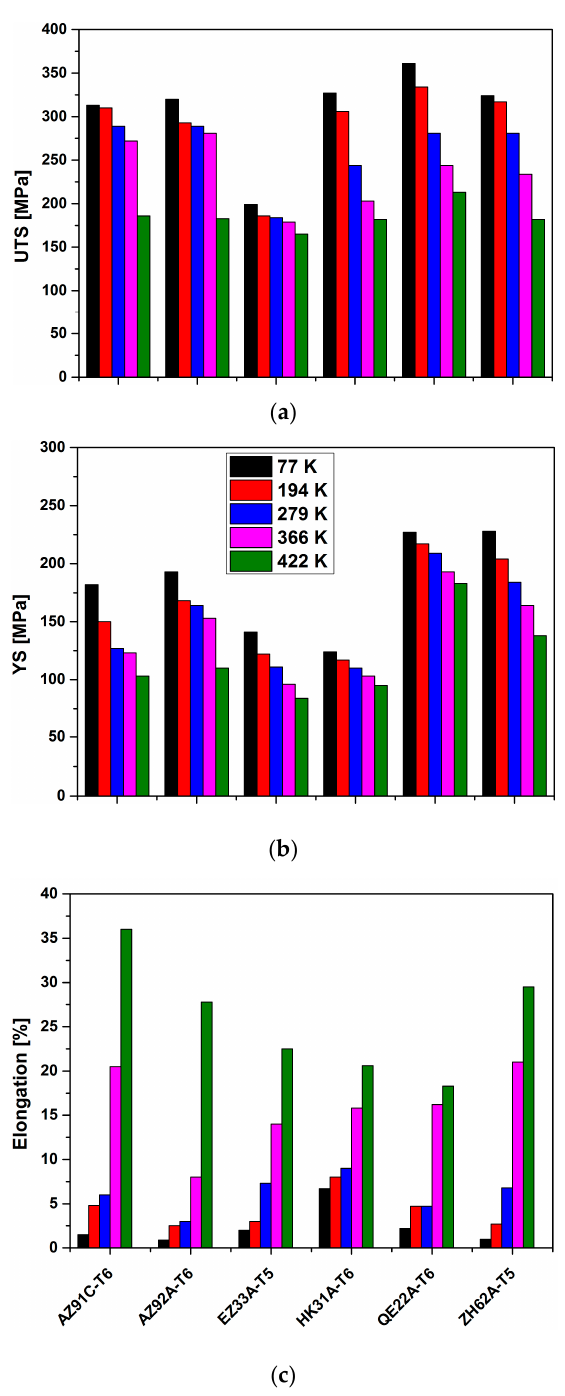
Figure 9. ( a ) UTS, ( b ) Yield strength, and ( c ) elongation of cast magnesium alloys at 77, 194, 279, 366, and 422 K (redrawn after